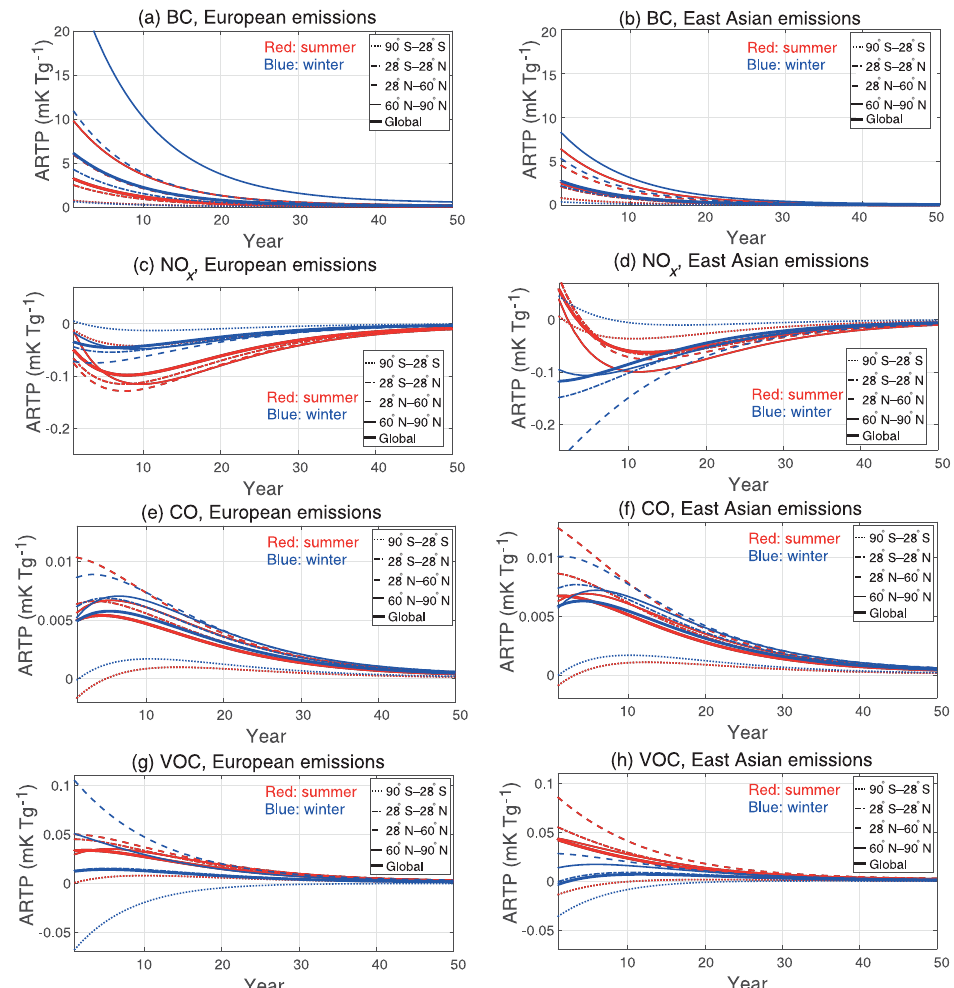
Figure 2. ARTP values in different response bands for BC and the ozone precursors for time horizons up to 50 years. Emissions in Europe (left) and East Asia (right) in NH summer (May–October) are given as red and in NH winter (November–April) as